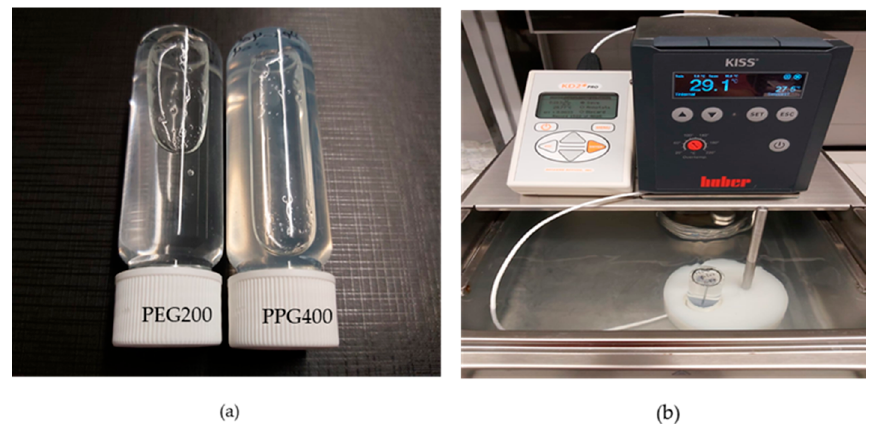
Figure 1. ( a ) Fumed silica particles dispersed in PEG200 (left) and PPG400 (right). The bubble flows slower in PEG200 than in PPG400 suspension due to the higher viscosity of the former. ( b ) Experimental set up for the thermal conductivity measurements. The sample is placed in a glass vial provided with a septum closure in which the needle of the probe is inserted.